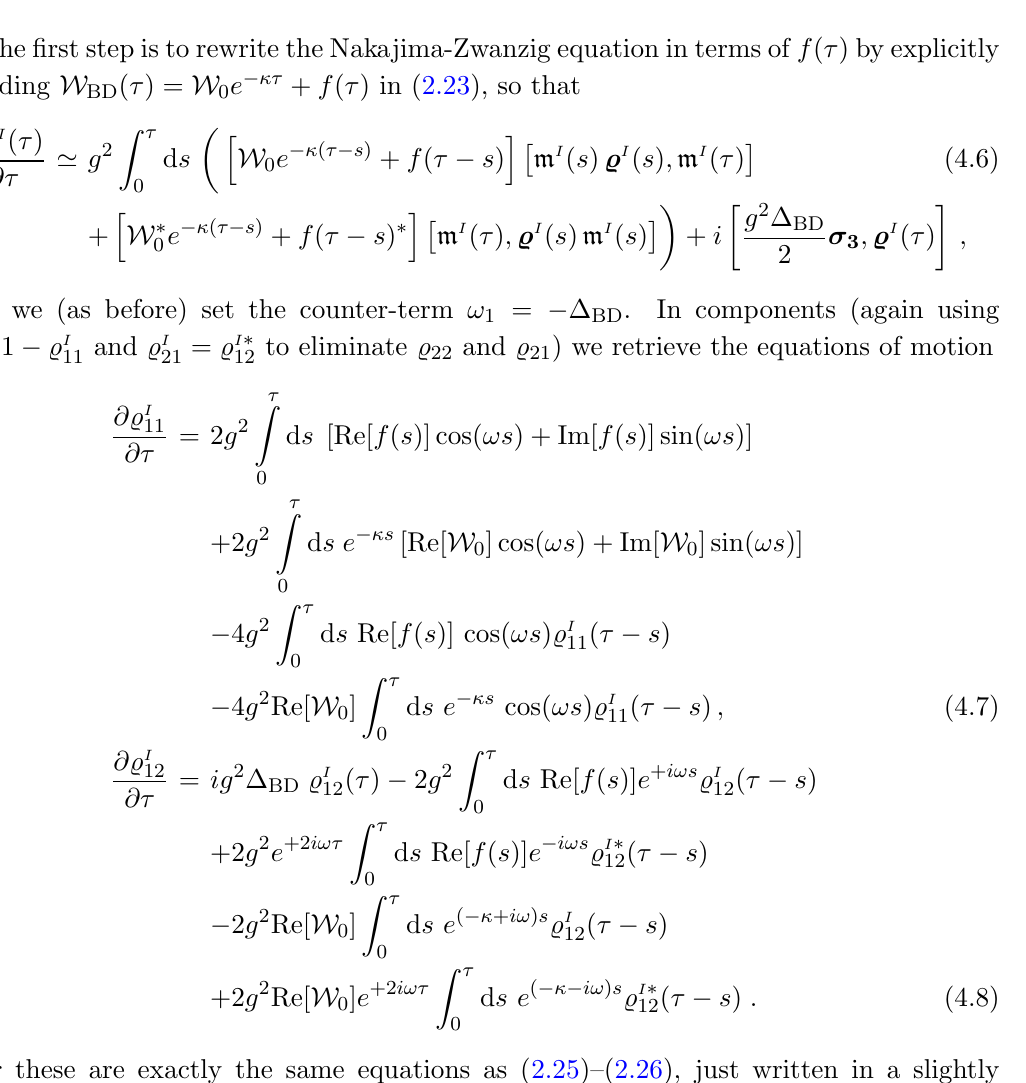
Table 5 . Leading-order behaviour for the functions ~ C BD , ~ C relative sizes of ! , M e(cid:11) and H , where M e(cid:11) =H (cid:28) 1. These functions are markedly better behaved near ( M e(cid:11) ; ! ) = (0 ; 0) than the functions listed in table 2.